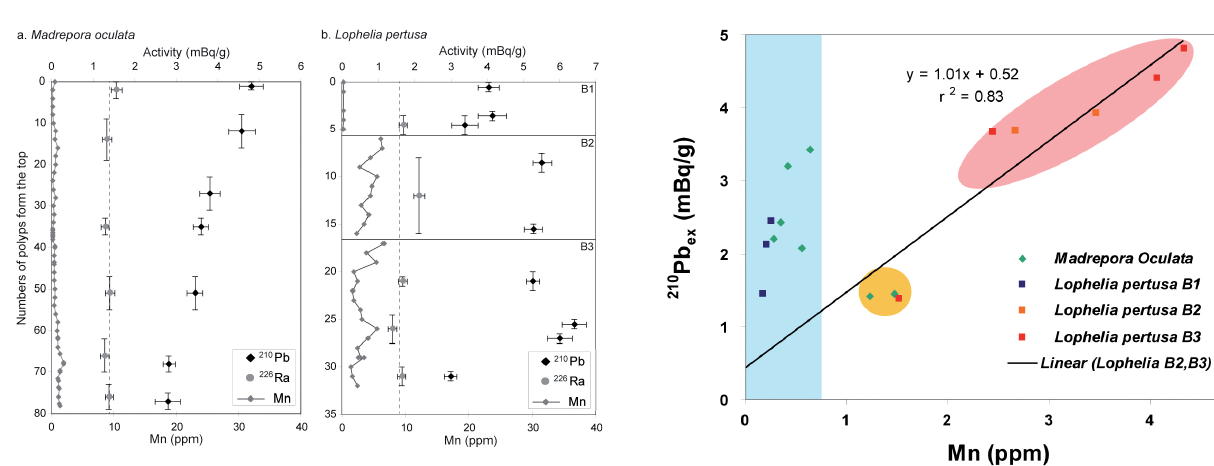
Fig. 5. 210 Pb excess versus Mn concentrations for the two Madrepora oculata and Lophelia pertusa specimens studied here. This graph reveals a marked link between the presence of Mn- oxydes and the level of 210 Pb excess for the older parts of each coral fragment. Such an effect strongly limits the use of the 210 Pb- 226 Ra method for older Mn-rich deep-sea corals. Red, orange and blue areas represent respectively highly, moderately and slightly Mn-contaminated coral